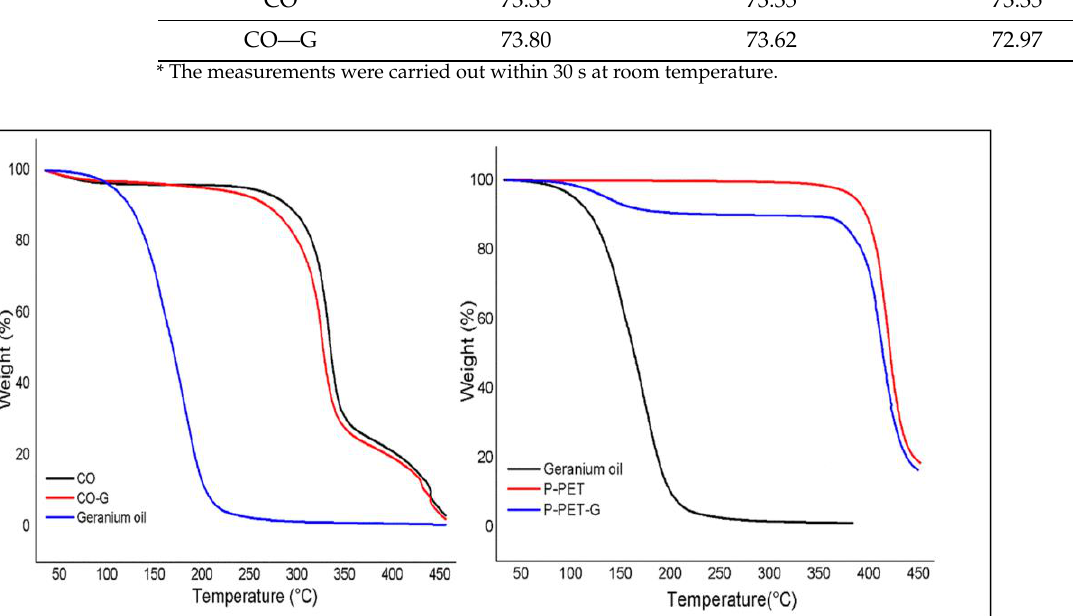
Table 4. Main features of cotton and polyester fabrics and their modified counterparts.